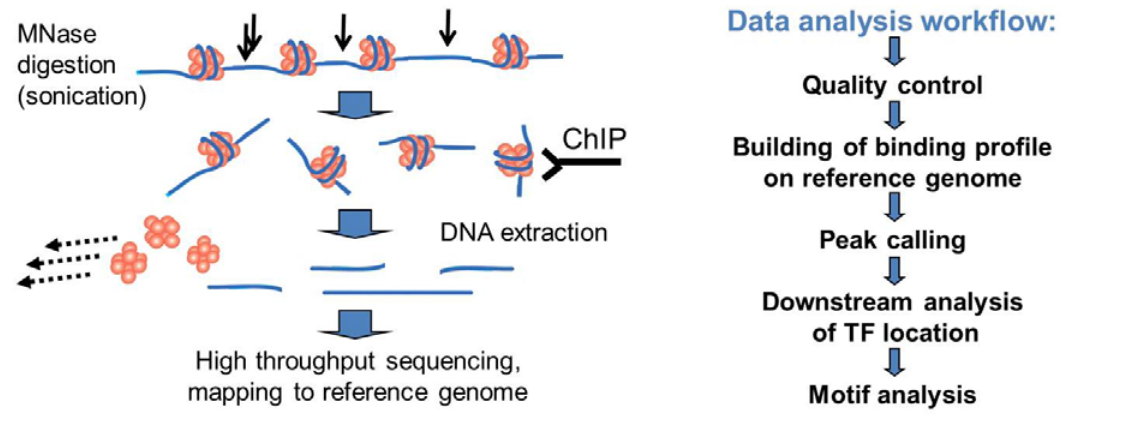
Figure 1: ChIP-seq workflow and data